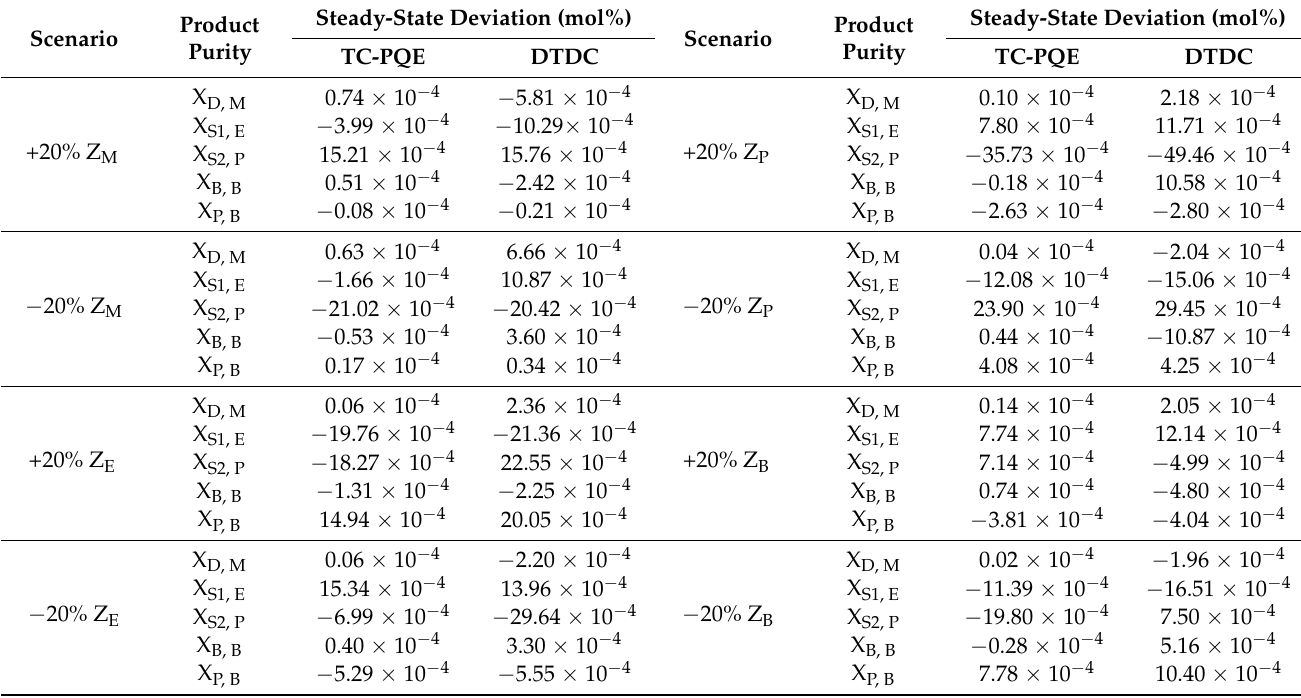
Table 6. Steady-state deviations for ± 20% variations in feed compositions of M, E, P, and B (Example